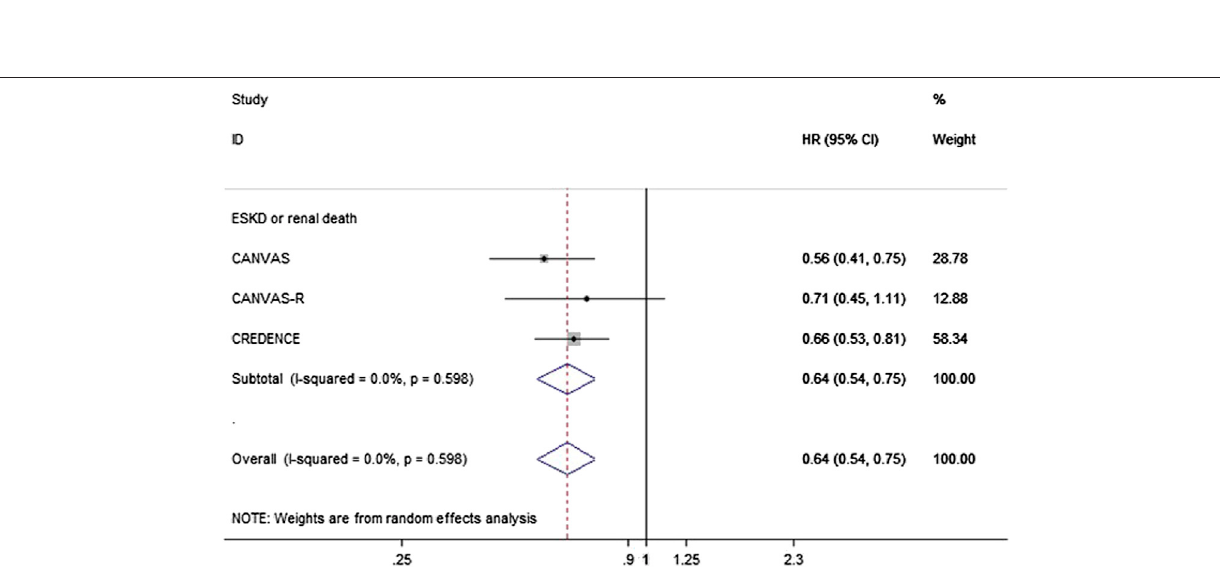
Frontiers in Pharmacology |